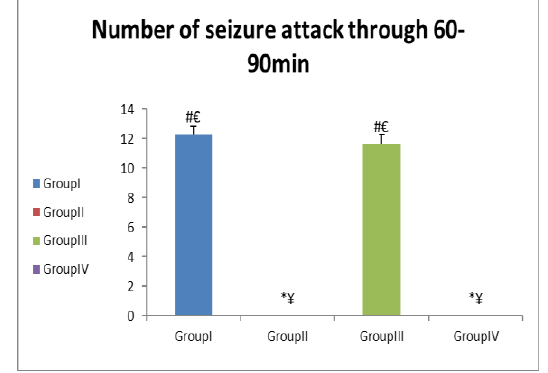
Figure 3. Mean±SE of the number of clonic seizures at 60-90min that induced by yohimbine HCl (Group I) and other treated groups (Diazepam+ yohimbine HCl(Group II), omega 3 fatty acids +yohimbine HCl (Group III) and omega 3 fatty acids +Diazepam + yohimbine HCl (Group IV). Symbol *refers to difference between group I and other groups. Symbol; # refers to difference between group II and other groups; symbol ¥ refers to difference between group III and other groups; and symbol € refers to difference between group IV and other groups.